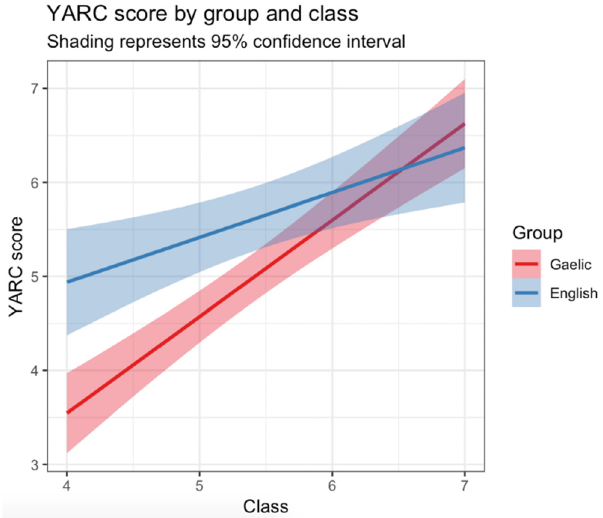
Figure 4. YARC performance by group (Gaelic and English), by